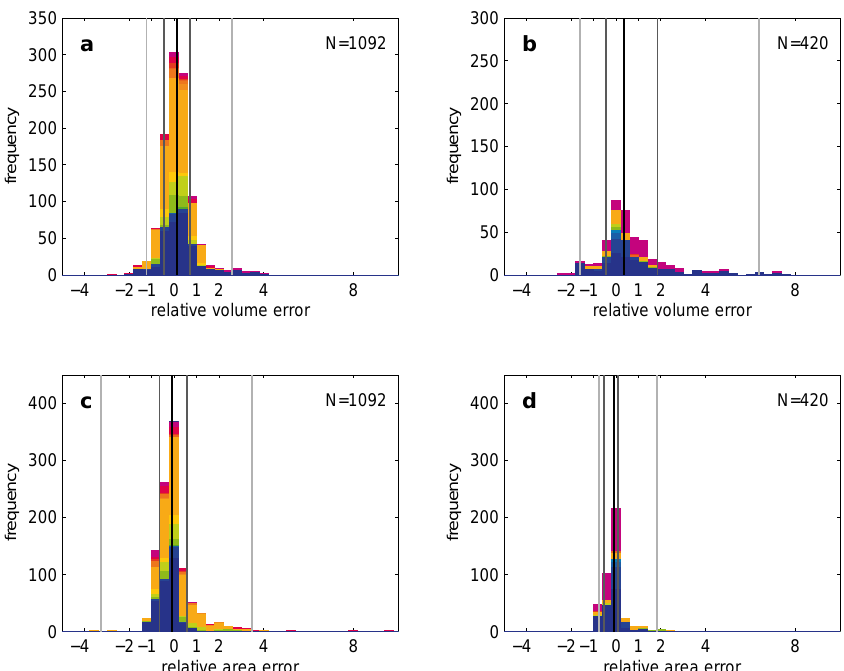
Fig. 14. Validation of temporally integrated modeled volume changes and surface areas, and propagated model errors; (a) distribution of relative volume errors of non-calving glaciers; (b) distribution of relative volume errors of calving glaciers; (c) distribution of relative surface area errors of non-calving glaciers; (d) distribution of relative surface area errors of calving glaciers; vertical lines indicate the 2nd and 98th percentiles (light gray), 15th and 85th percentiles (dark gray), and median (black); numbers indicate sample